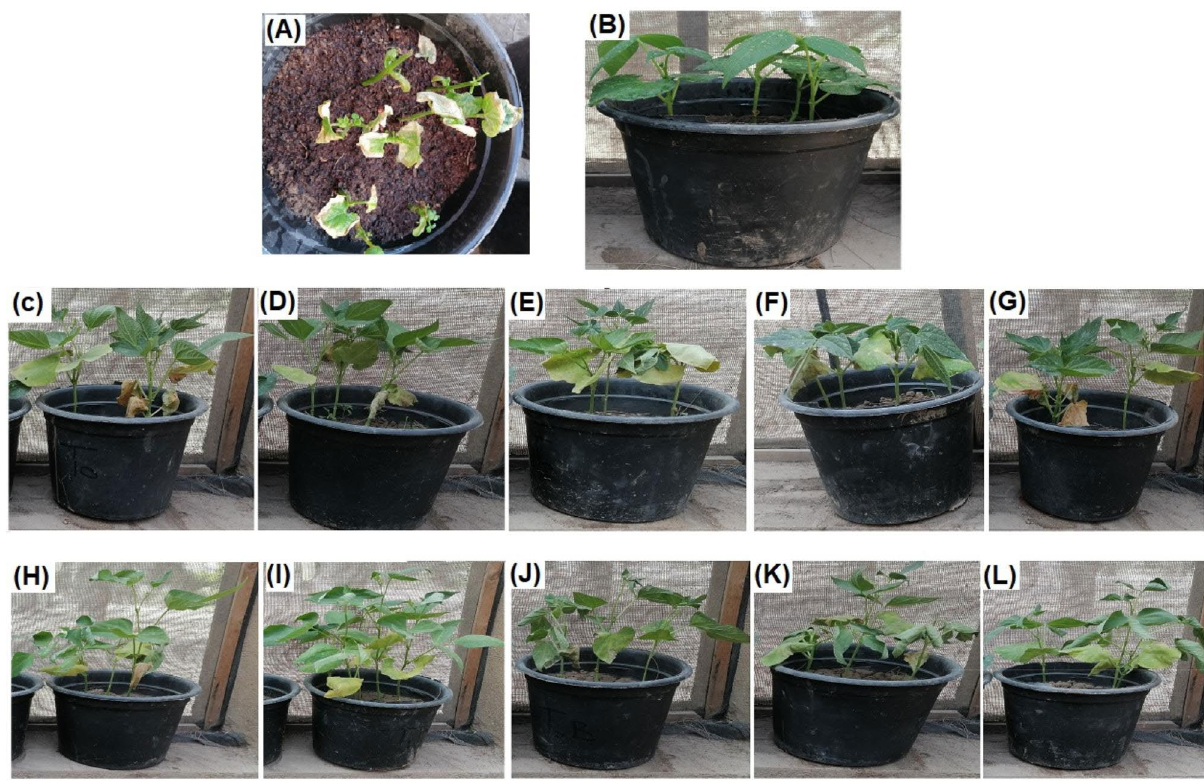
Fig. 1 Photographs of the Phaseolus vulgaris plant controls; Infected un-treated (A) , Un-infected (B) , the therapeutic plan; Treatment with Co 3 O 4 NPs (C) , Treatment with CuONPs (D) , Treatment with Fe 3 O 4 NPs (E) , Treatment with NiONPs (F) , and Treatment with ZnONPs (G) , and the protective plan; Treat- ment with Co 3 O 4 NPs (H) , Treatment with CuONPs (I) , Treatment with Fe 3 O 4 NPs (J) , Treatment with NiONPs (K) , and Treatment with ZnONPs Table 4 Measured vegetative growth parameters of different treatment plans against wilt disease Treatments Plant height No of leaves Root length Fresh weight Dry weight (cm) per plant (cm) (g/plant) (g/plant) Control